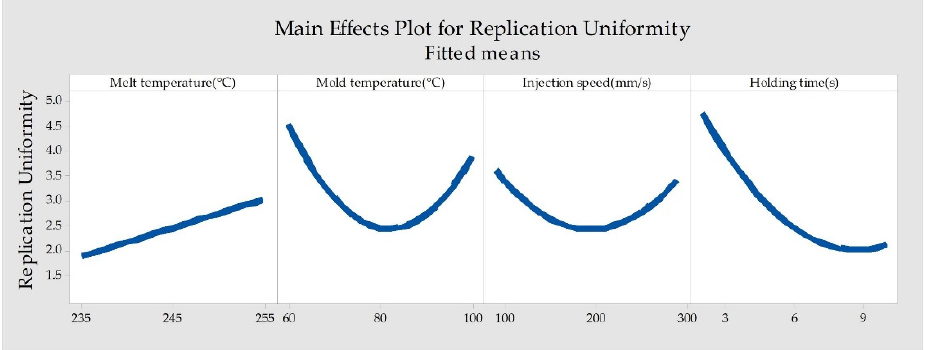
Figure 8. Main effects plot for replication uniformity.